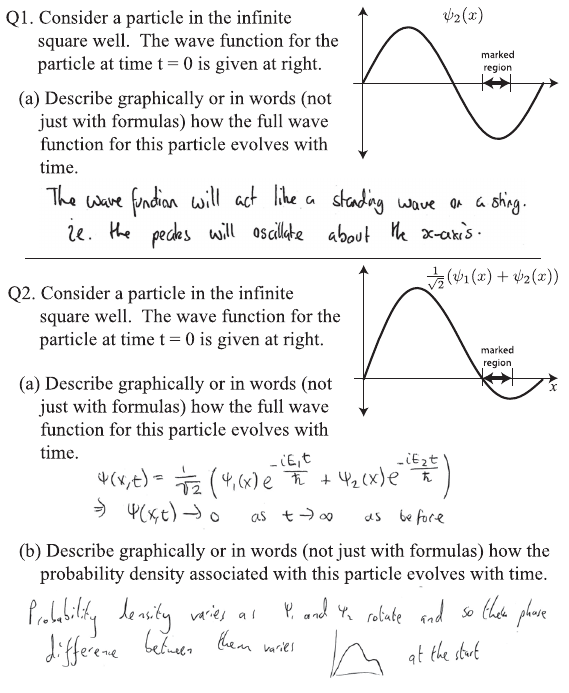
FIG. 3. Abbreviated versions of the three pre- and midtest questions administered before and after the activity discussed in Sec. III A. All three questions also included the instruction: “ If it does not depend on time, state so explicitly. ” Examples of three different student responses are also shown. Using the framework in Sec. II D, these responses were coded as incorrect classical visual (1a), incorrect complex mathematics (2a), and correct quantum visual (2b).